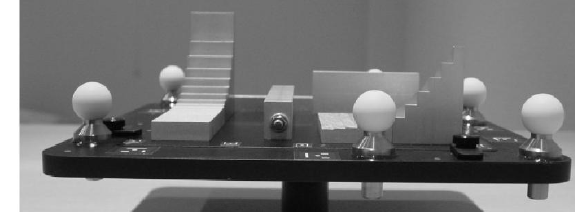
Figure 2. The portable metric test object. Base plate seen from the side, surrounded by calibrated lambertian tooling balls raised on a stainless steel collar, for consistent registration.